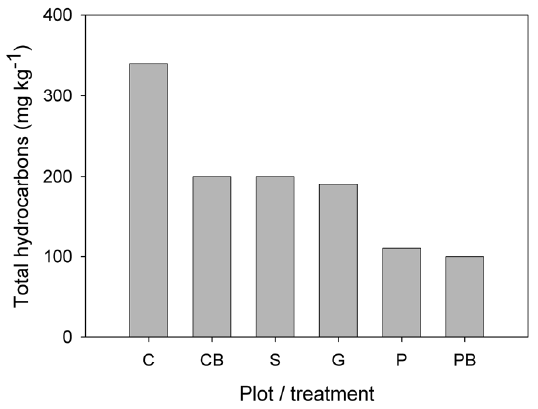
Fig 2. Effect of the treatment on the concentration of total hydrocarbons in semi-coke. Sample codes are given in